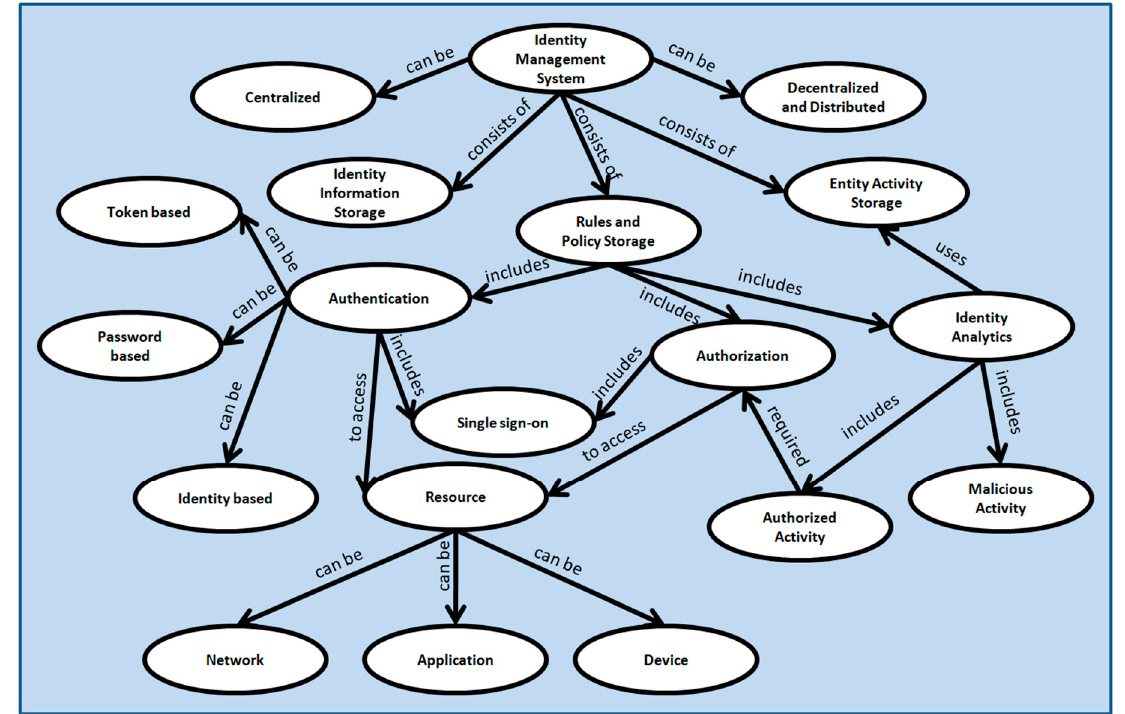
Figure 6. IoT identity management taxonomy visualized as a semantic network.